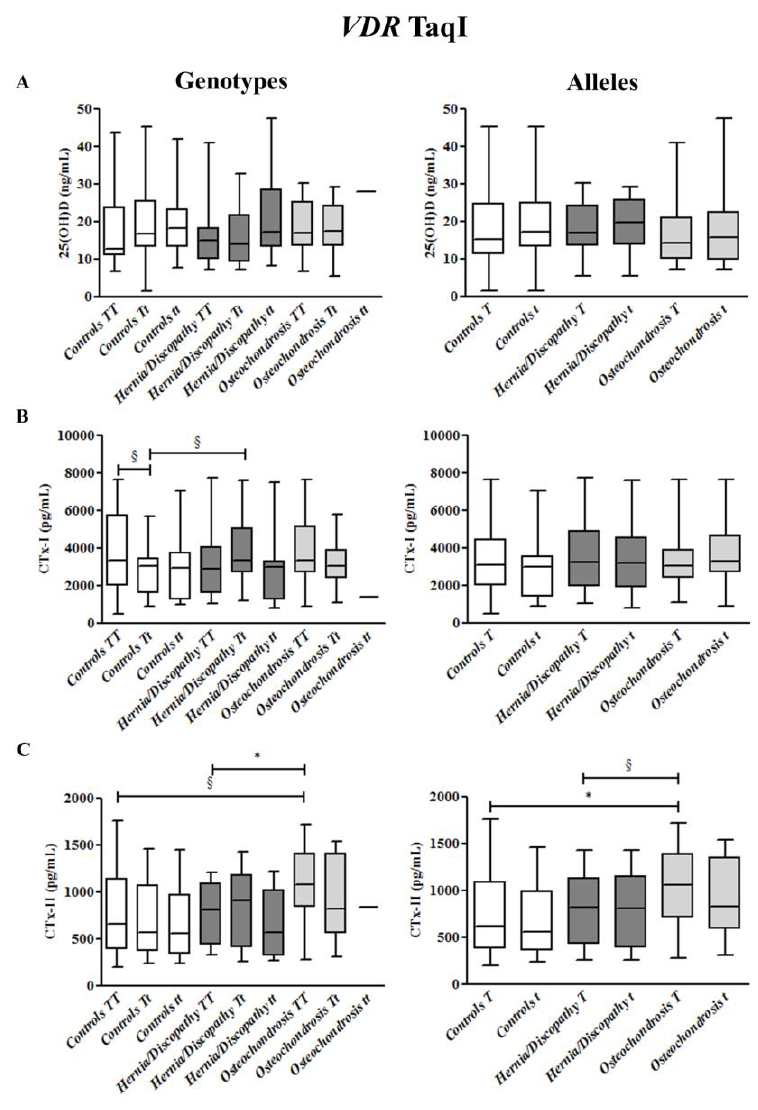
Figure 3. 25hydroxyvitamin D (25(OH)D) ( A ), cross-linked C-telopeptides of type I collagen (CTx-I) ( B ), and cross-linked C-telopeptides of type II collagen (CTx-II) ( C ) plasma concentrations in controls and in the subgroups of patients with hernia/discopathy and osteochondrosis, distributed according to TaqI VDR genotypes/alleles. The box and whisker plots show the median, 25th, and 75th percentile (interquartile) (the box), and minimum and maximum value (the whiskers). * p < 0.05. § indicates a tendency.